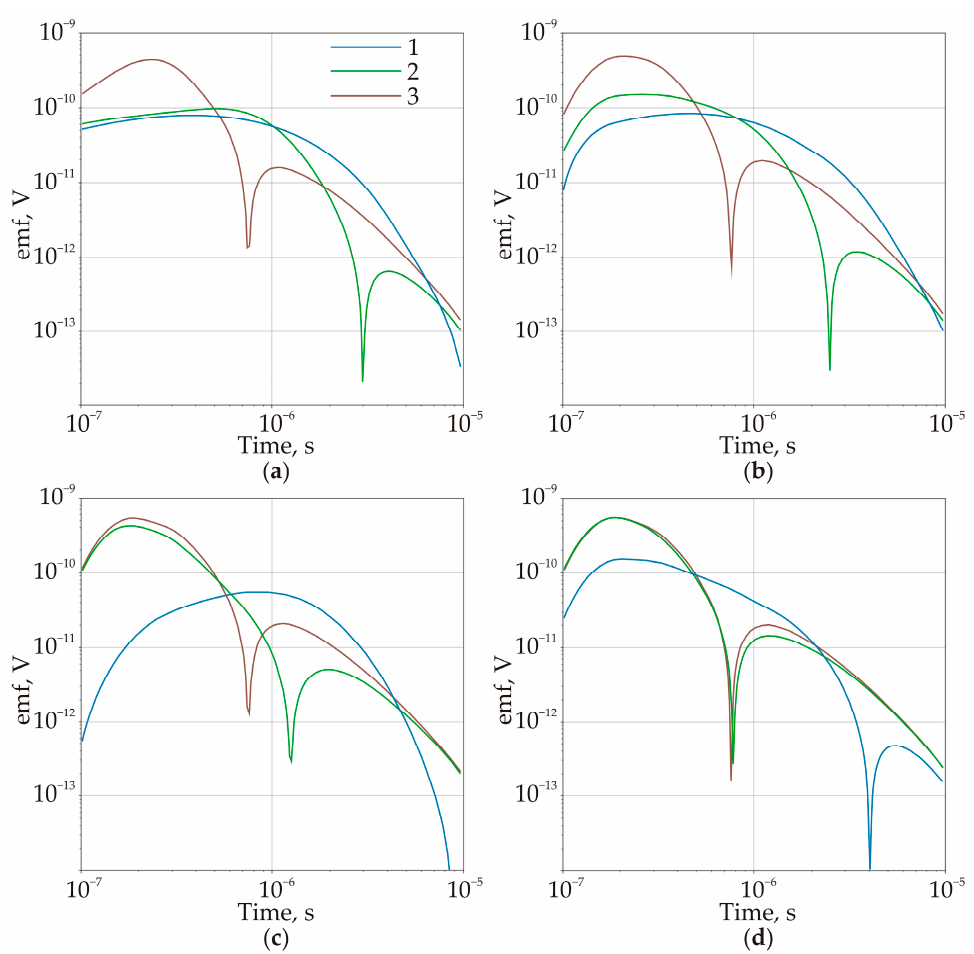
Figure 6. Temporal variations of the electromotive force in the receiver coil at four characteristic depths (( a )—1 m, ( b )—5 m, ( c )—10 m, ( d )—15 m) when the source and receiver move down the wellbores opposite each other. Key: 1 is reference model, 2 is small talik, 3 is large talik.